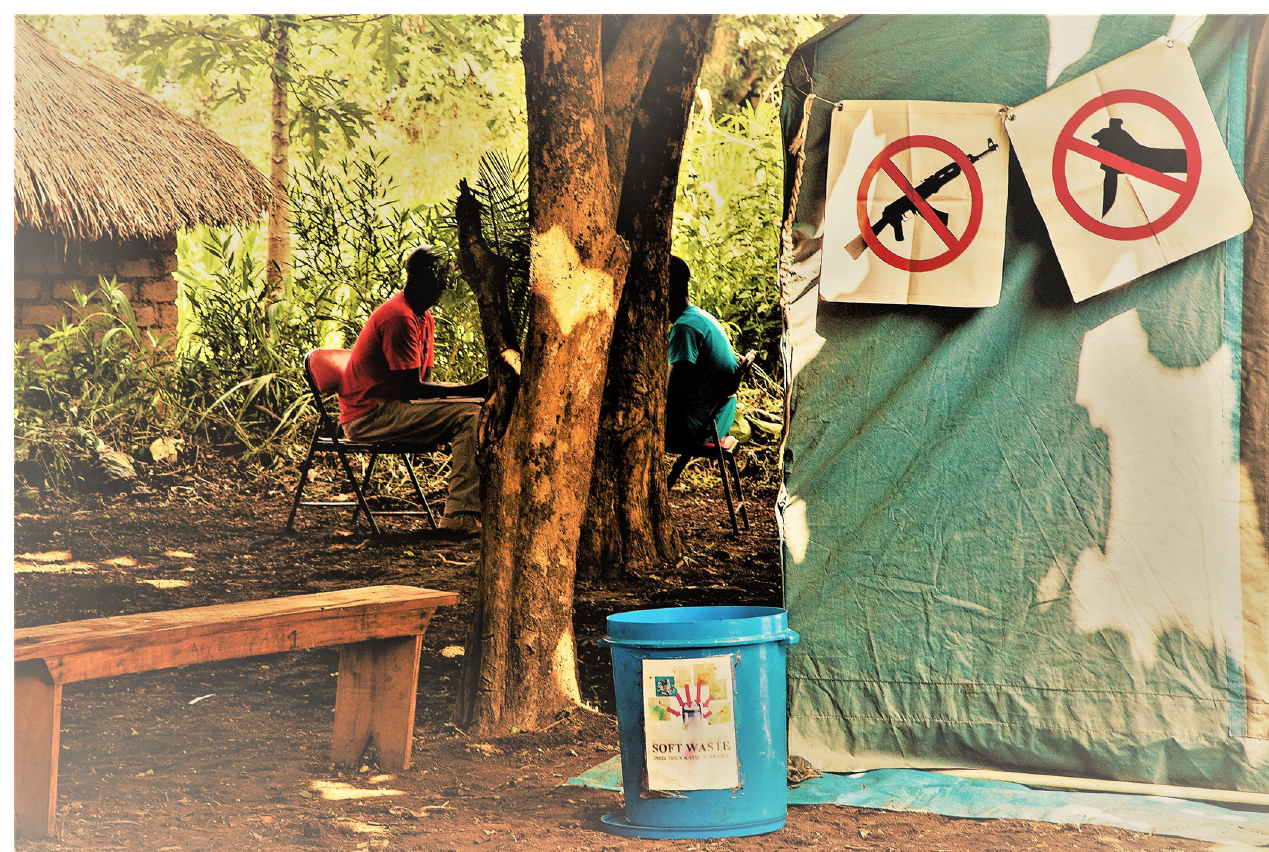
Fig 1. Individual counselling session at community